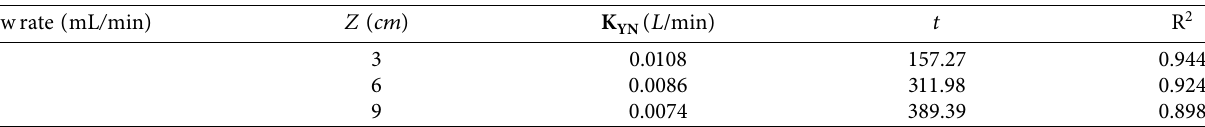
Figure 8: Yoon–Nelson plot for cadmium removal at different bed depths. (a) Bed depth of 3cm. (b) Bed depth of 6 cm. (c) Bed depth of 9cm. Table 7: Yoon–Nelson parameters for cadmium